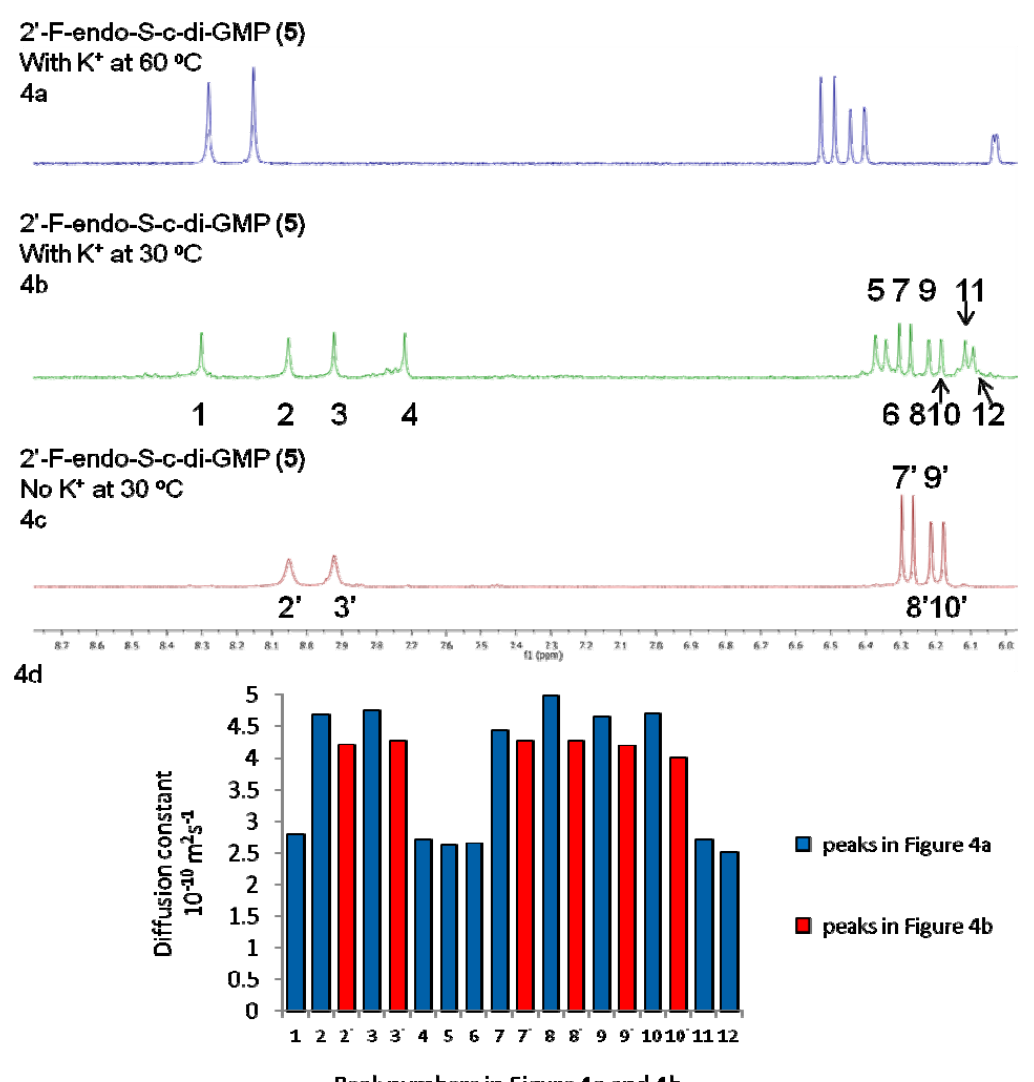
Figure 4. 1 H-NMR stacked spectra of 3.0 mM analogue 5 in D c-di-GMP, 100 mM KCl, 60 °C. ( b ) 3.0 mM 2'-F-endo-S-c-di-GMP, 100 mM KCl, 30 °C. ( c ) 3.0 mM 2'-F-endo-S-c-di-GMP, no metal cation, 30 °C. ( d ) 3.0 mM 2'-F-endo-S-c-di- GMP, T /T relaxation analysis (from DOSY 1 2